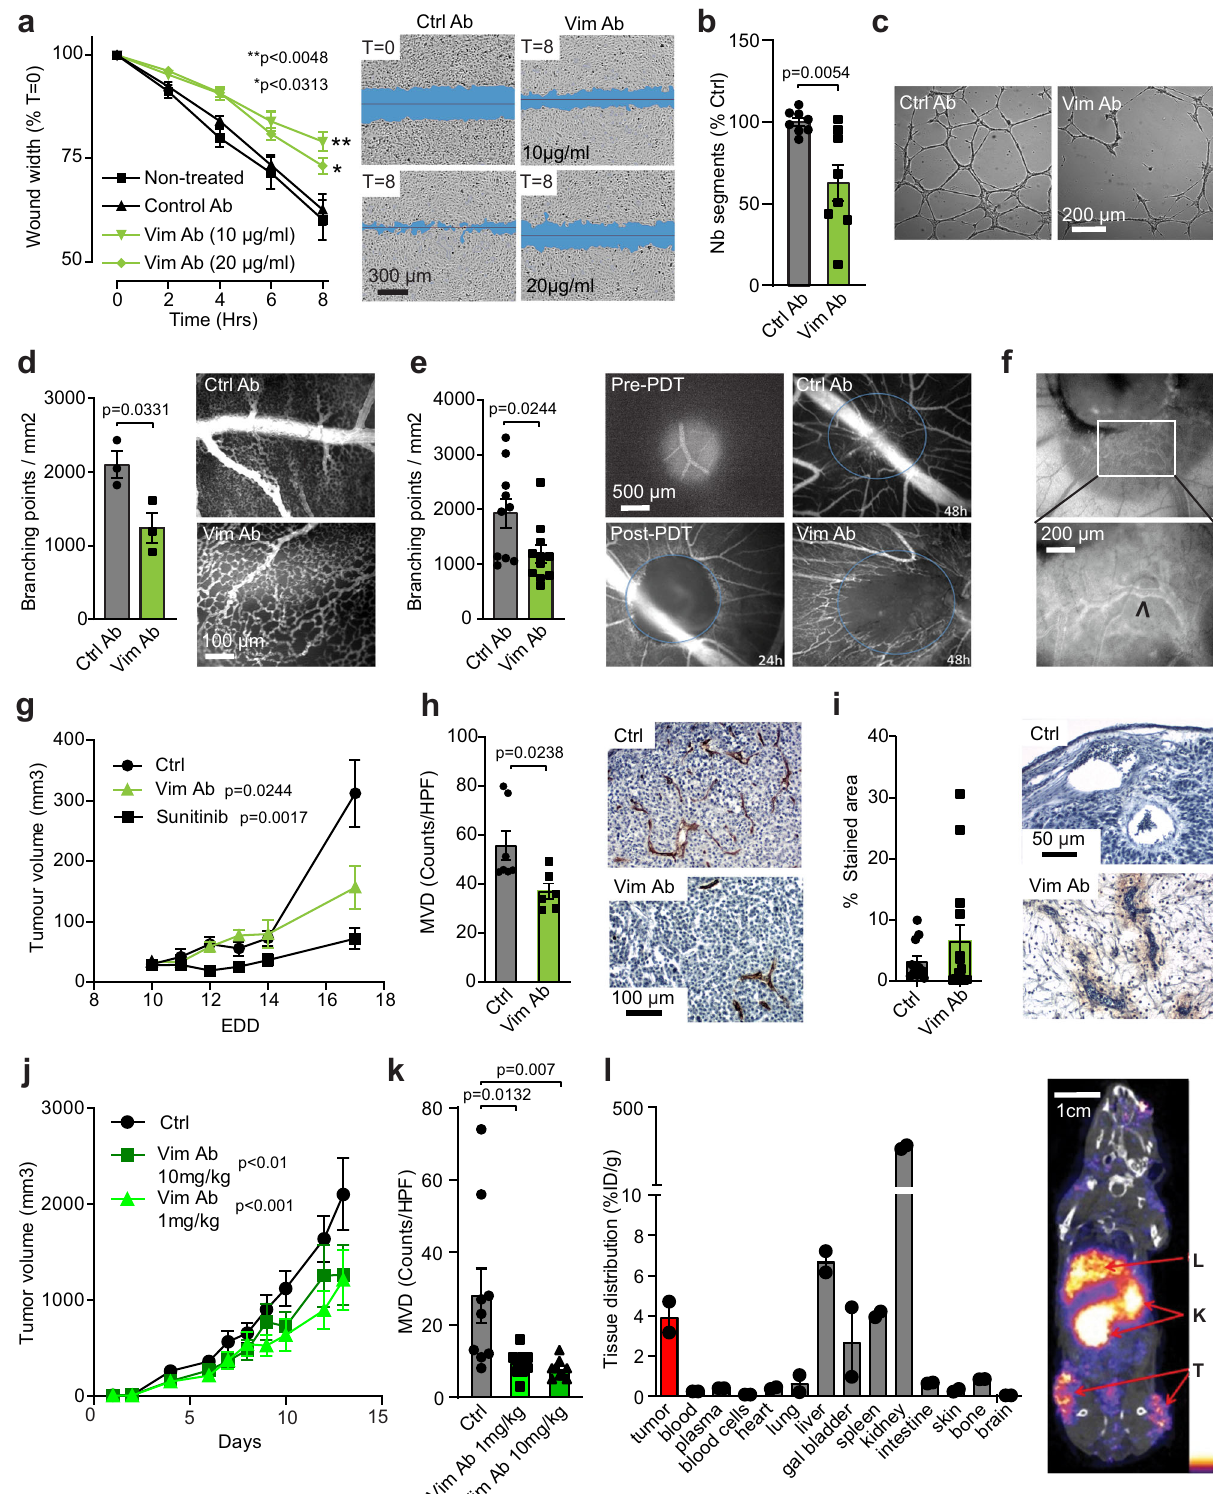
in non-ECs (Fig. 5b), mRNA expression of the blood vessel- speci fi c adhesion molecule Vcam1 was markedly increased in tumors of vimentin-vaccinated mice (Fig. 5b). Concordantly, staining of B16F10 tumor sections of vimentin-vaccinated mice for Pd-l1 revealed that vascular expression was reduced (Fig. 5c), as was supported by mRNA analysis (Fig. 5d). Together, these